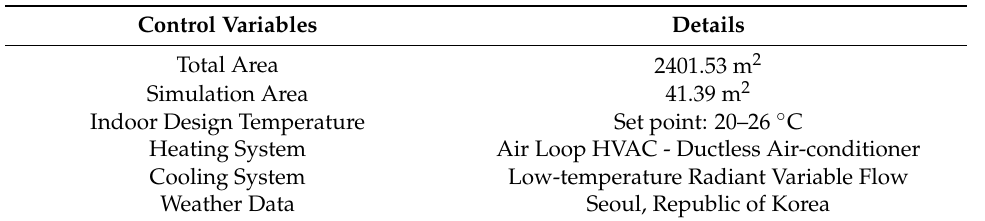
Table 3. Simulation conditions.